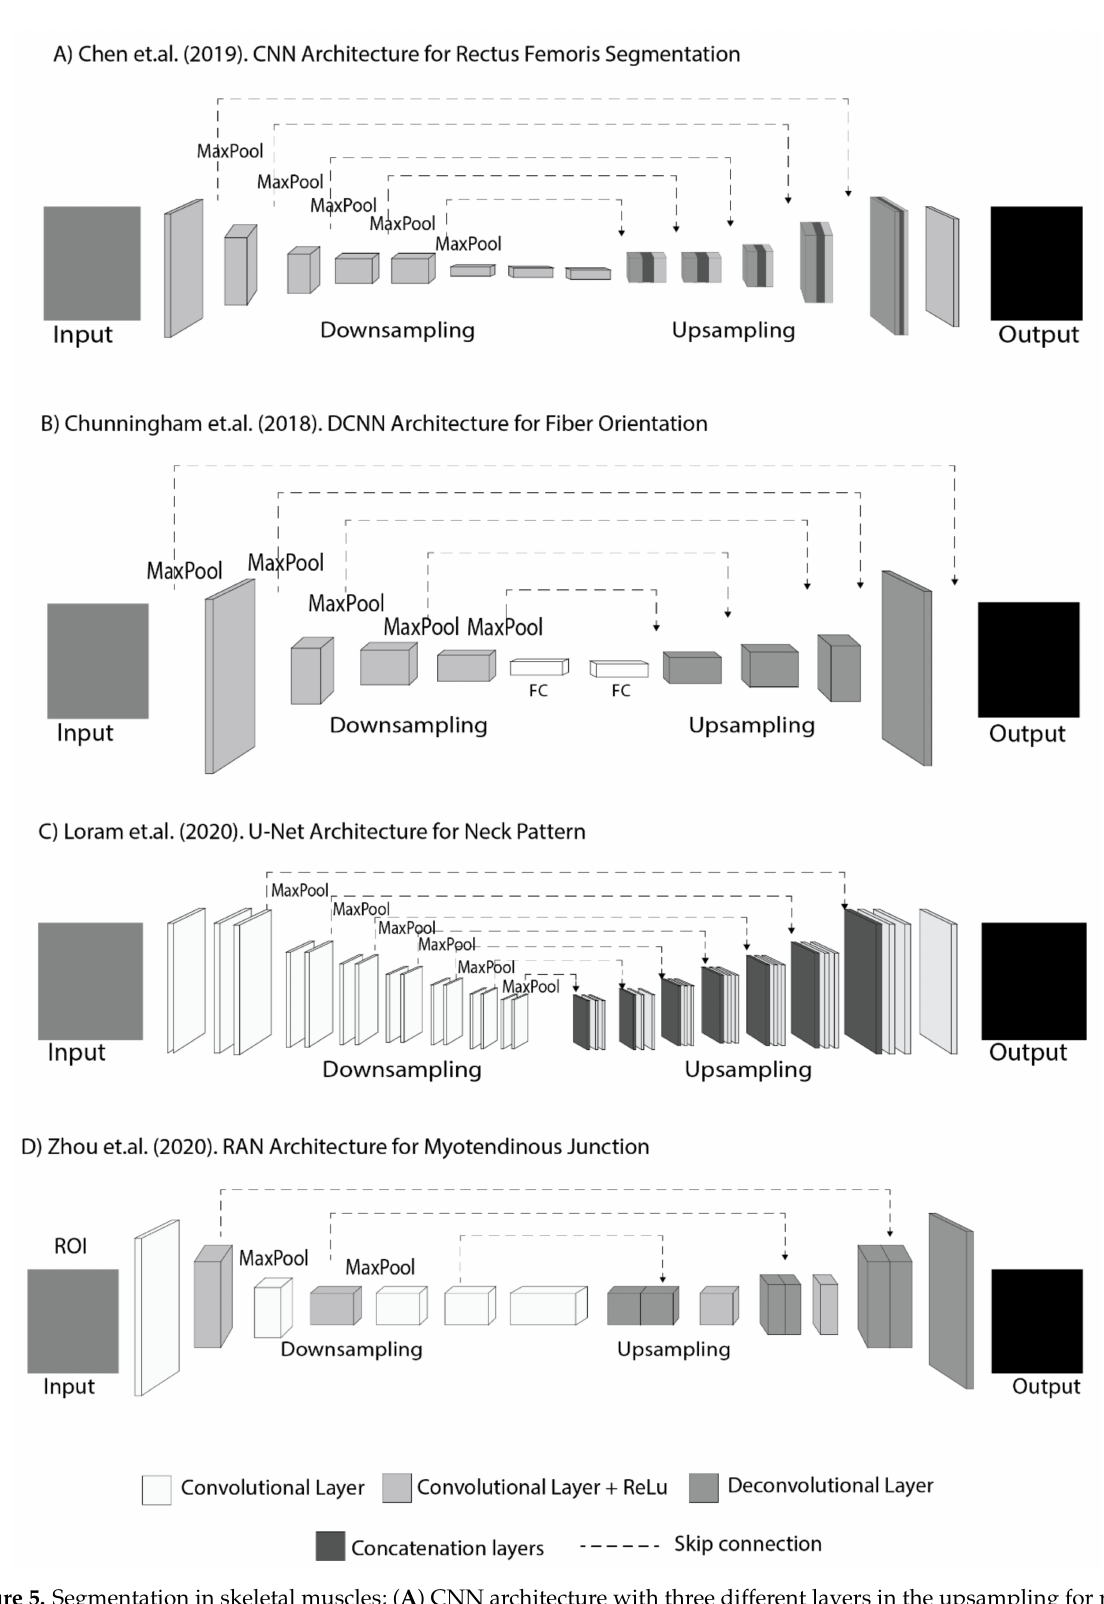
Figure 5. Segmentation in skeletal muscles; ( A ) CNN architecture with three different layers in the upsampling for rectus femoris segmentation. ( B ) DCNN architecture with fully connected layer for segmenting fiber orientation. ( C ) U-Net architecture with two different layers in upsampling for neck muscle pattern segmentation. ( D ) RAN architecture with two different layers for downsampling and upsampling for tracking the myotendinous